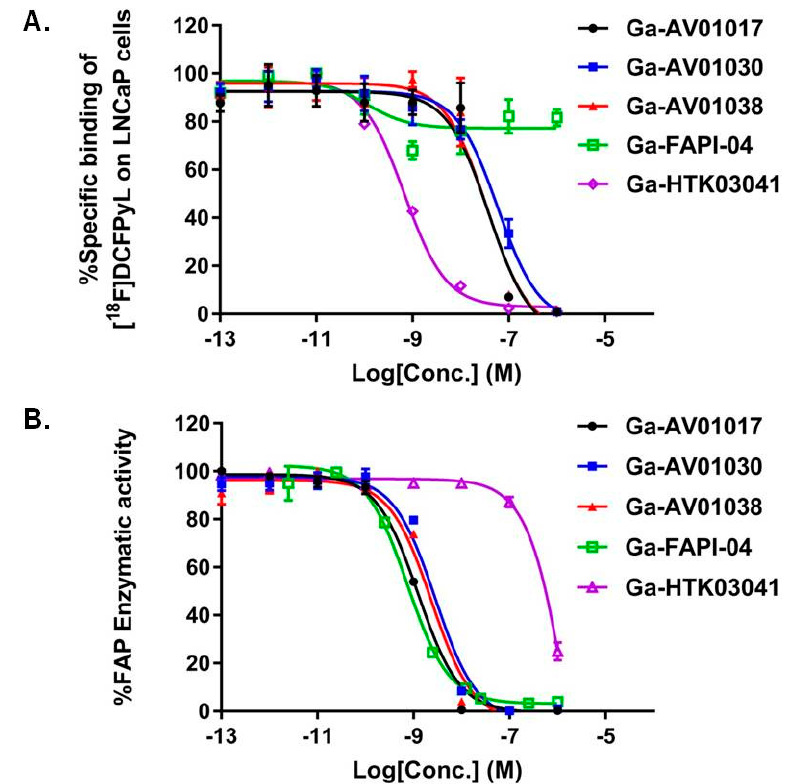
Figure 3. ( A ) Displacement curves of [ 18 F]DCFPyL by Ga-AV01017, Ga-AV01030, Ga-AV01038, Ga- FAPI-04, and Ga-HTK03041 generated using PSMA-expressing LNCaP cells; ( B ) Fluorescence